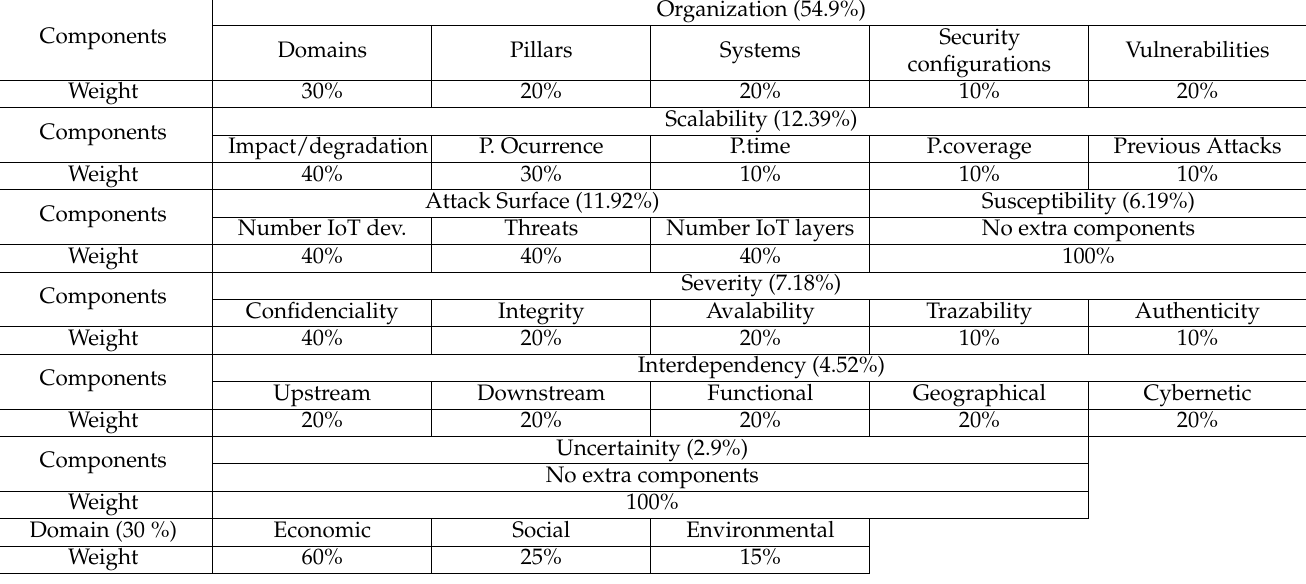
Table 8. MCDA to evaluate the security risk value for IoT systems.